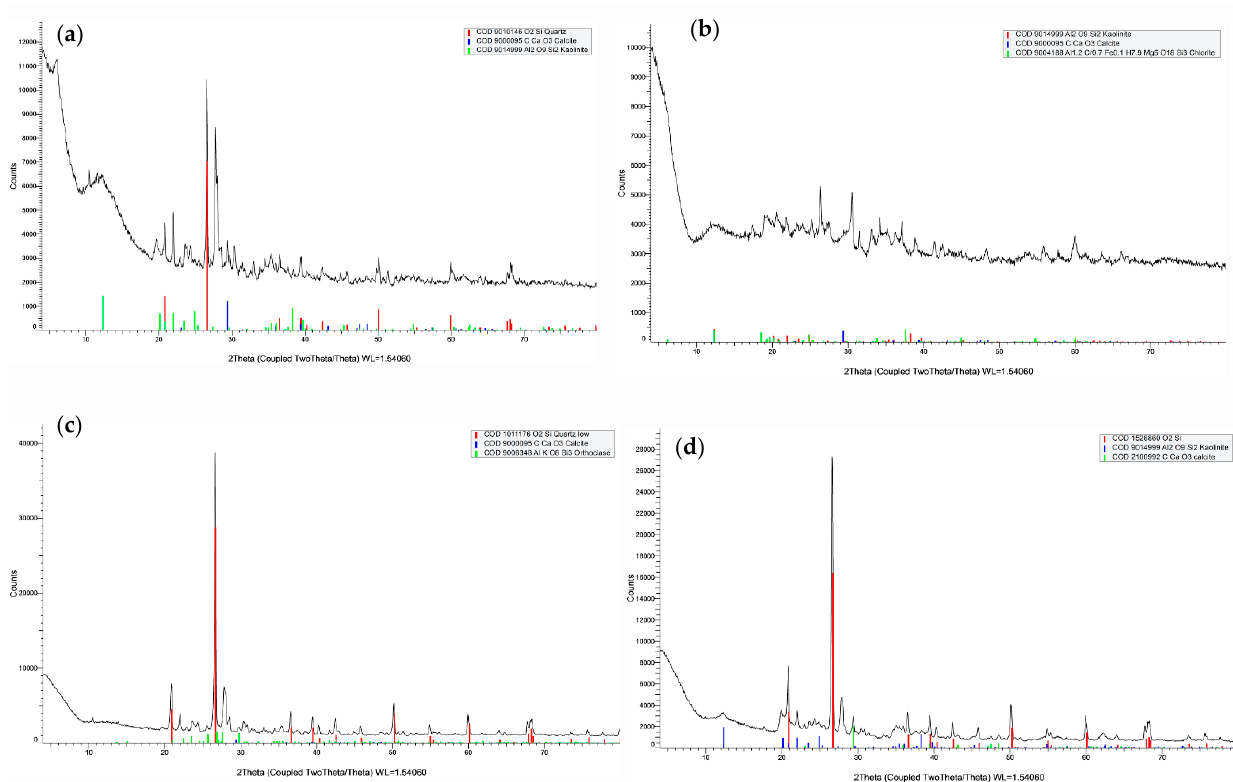
Remote Sens. 2021 , 13 , x FOR PEER REVIEW Figure 11. XRD analysis of the hydrothermal alteration zones. Figure 11. XRD charts of the hydrothermal alteration zones show presence of ( a ) quartz, calcite and kaolinite, ( b ) kaolinite, calcite and chlorite, ( c ) quartz, calcite and orthoclase, and ( d ) quartz, kaolinite and calcite.